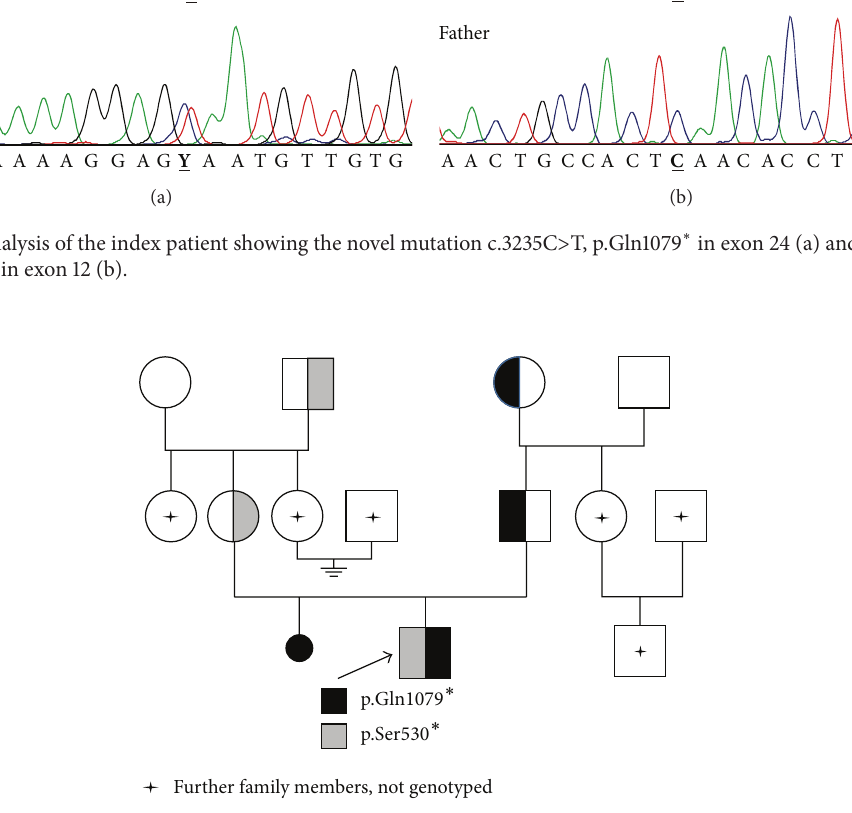
Figure 2: Diagnostic sequence analysis of the AGL gene (exons 12 and 24) shows compound heterozygosity for c.1589C > G, p.Ser53 0 ∗ and c.3235C > T, p.Gln107 9 ∗ in the index patient, and heterozygosity for either c.1589C > G, p.Ser53 0 ∗ or c.3235C > T, p.Gln107 9 ∗ in his parents and